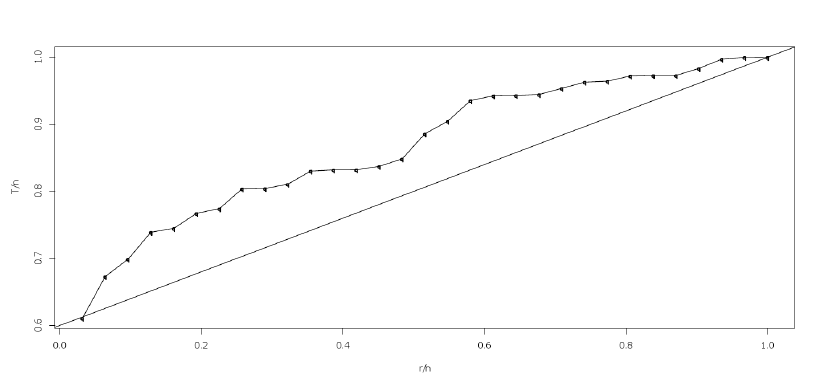
Figure 8 – TTT plot for glass airplane window